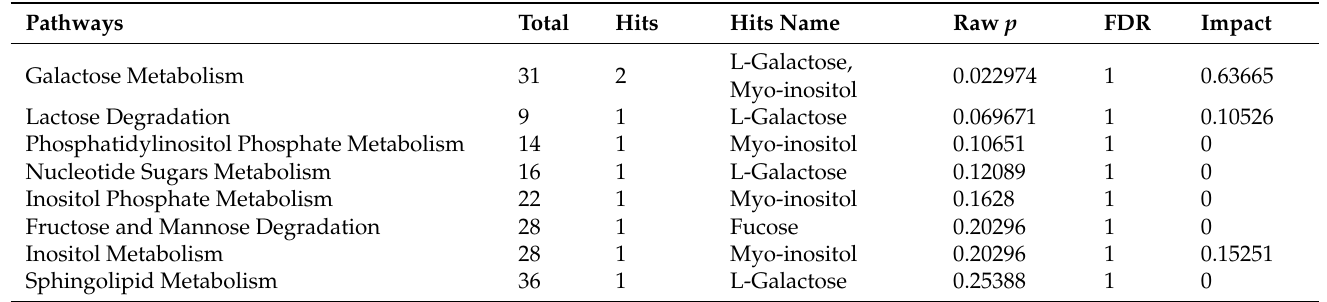
Table 2. List of altered metabolic pathways for β -thalassemia in comparison with untreated control and treated mice.